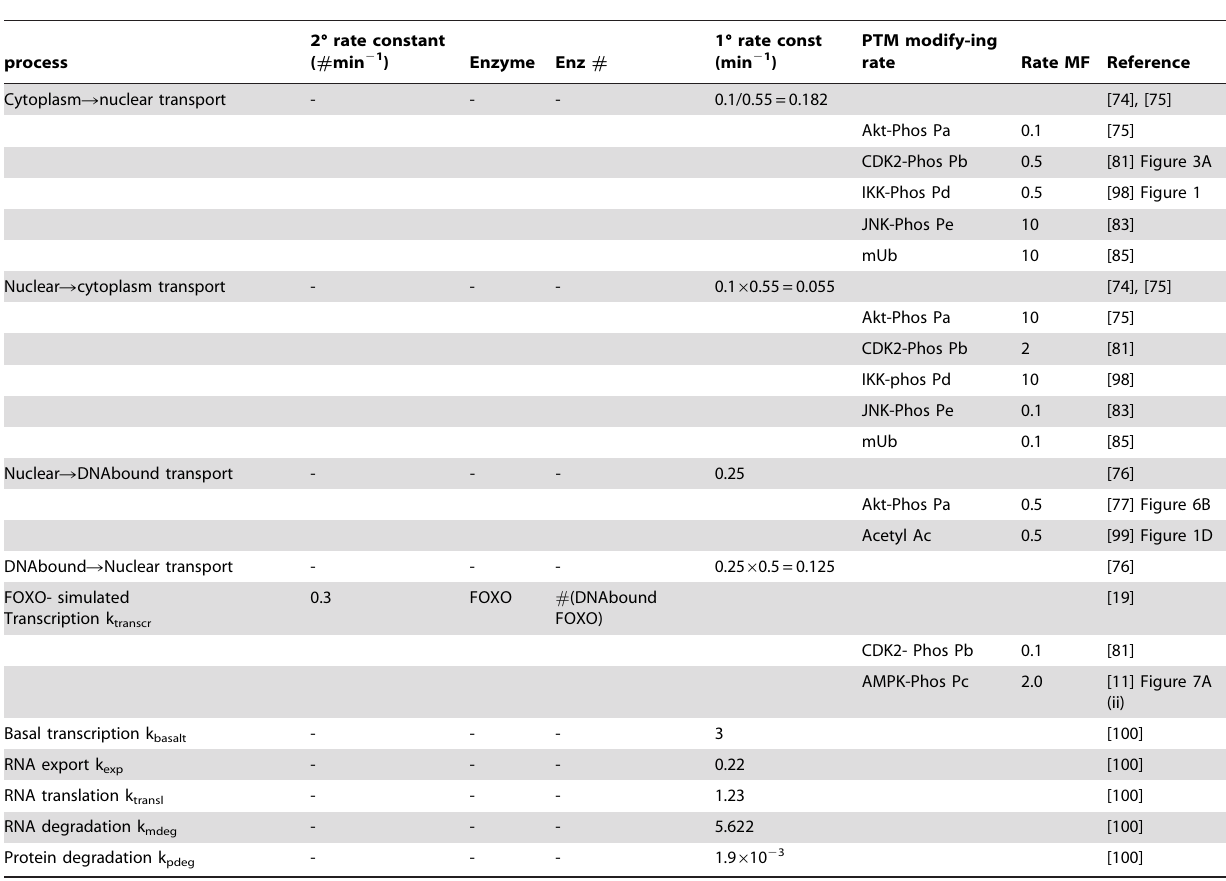
Table 2. Parameters of the model (transport of FOXO and processes involving FOXO-regulated genes).